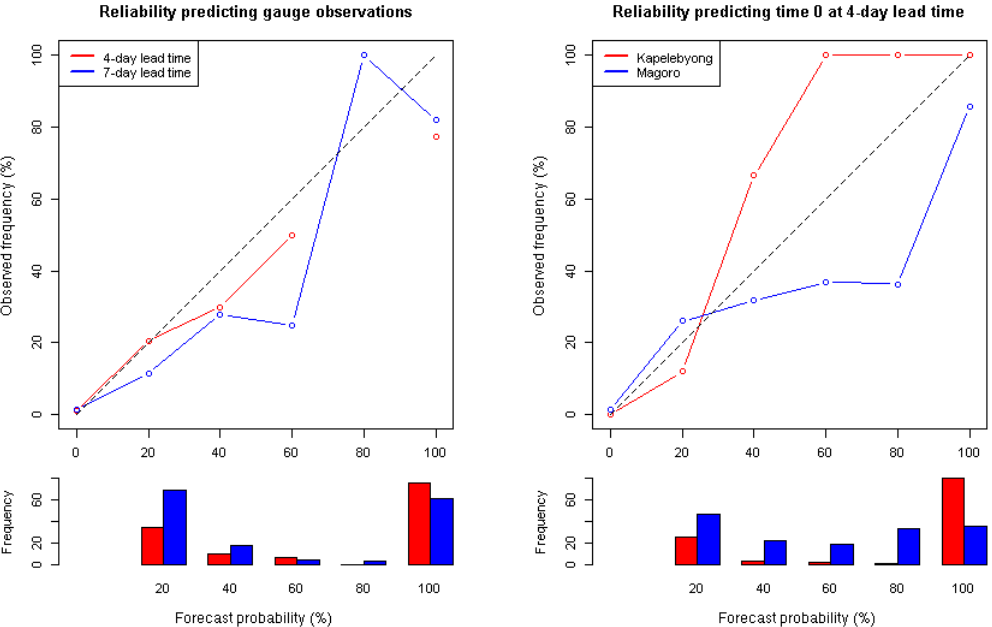
Figure 3. Reliability diagram for the gauge location (left) and the two project locations (right). This shows how many times a flood occurred for each forecast probability category. For the gauge location, GloFAS forecasts at two lead times on the Akokoro River are compared with gauge discharge (left). At the two project locations, GloFAS 4-day lead-time forecasts are compared with 0-day forecasts. Seven-day forecasts are not shown in the right panel, as results are very similar to the 4-day plots. The frequencies of forecast probabilities of 0% are 1688, 1655, 1702, and 1658, for Gauge 4-day, Gauge 7-day, Kapelebyong, and Magoro, respectively. These are not plotted in the frequency bar graph as they would extend past the scale. Lastly, due to sampling uncertainty, 95% confidence intervals extend nearly from 0 to 1, and are therefore not